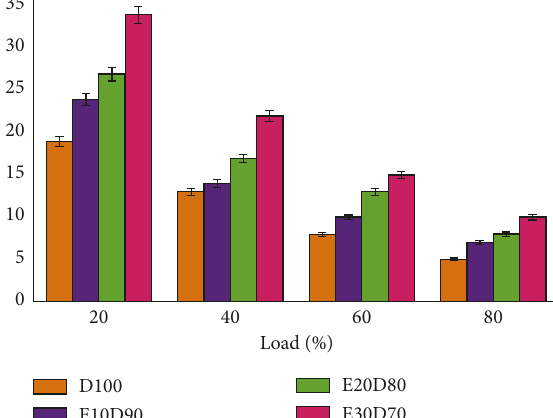
Figure 6: Variation in BSFC with EGR (0%, 10%, and 20%) at 60% load.